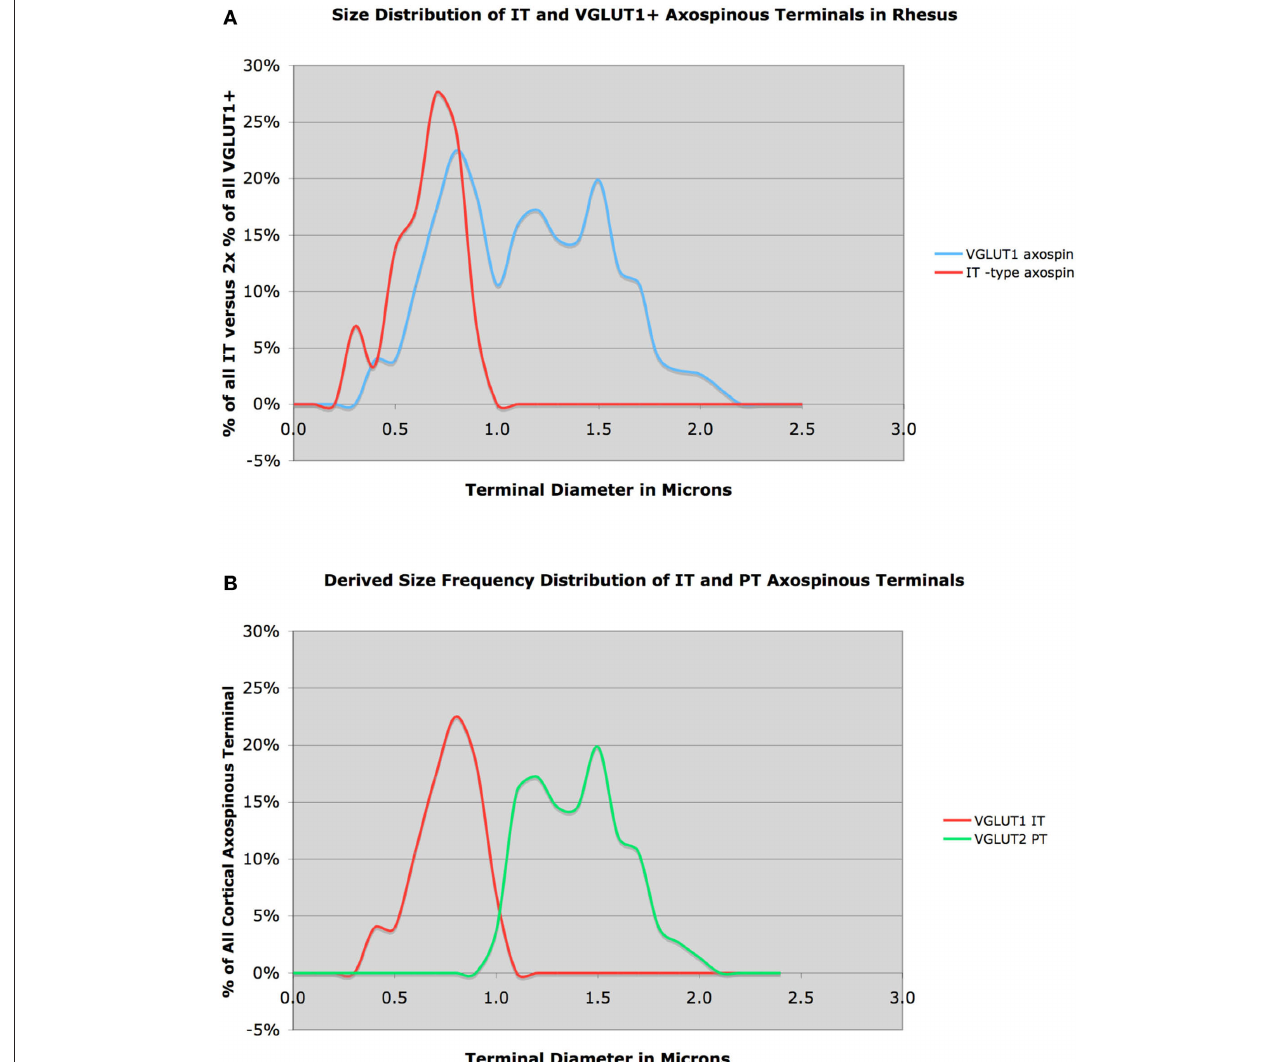
Figure 4 | graph (A) shows the size frequency distribution of VGLUT1+ corticostriatal axospinous terminals (blue) in rhesus monkey, compared to the size frequency distributions for IT-type axospinous terminals (red) in striatum. Note that the IT-type distribution largely coincides with the VGLUT1 peak at